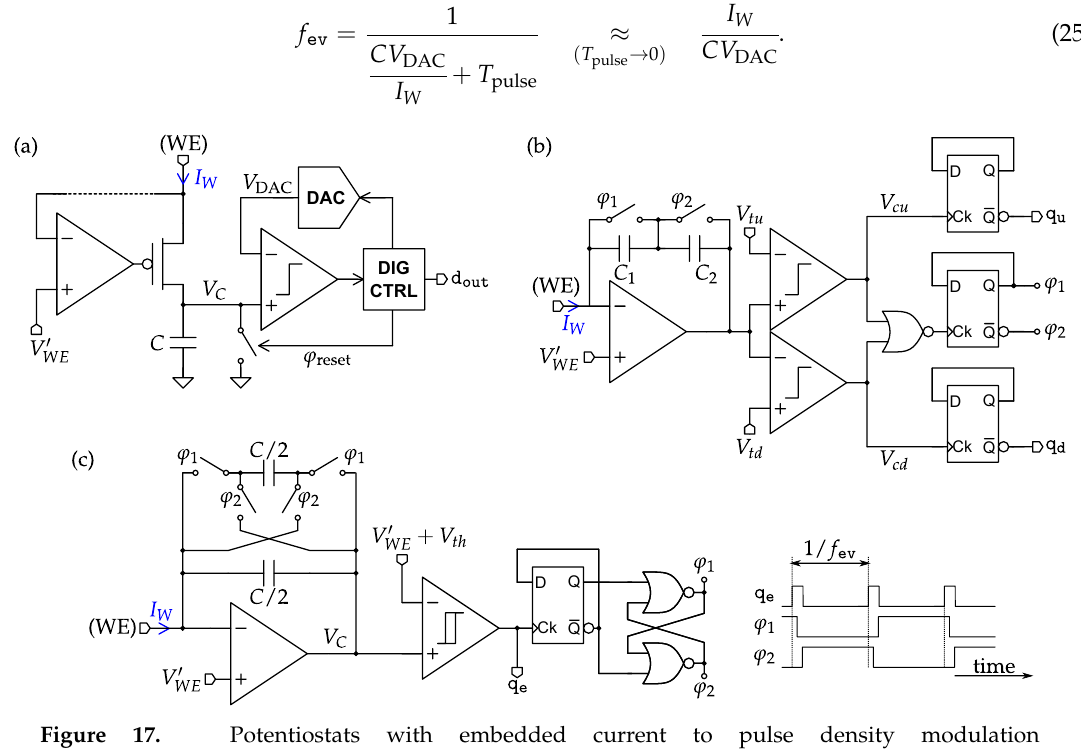
Figure 17. Potentiostats with embedded current to pulse density modulation (I-to-pulse-density-modulation type). ( a ) based on current buffer; ( b ) based on transimpedance amplifier with double integrating capacitor; ( c ) based transimpedance amplifier with soft-reset